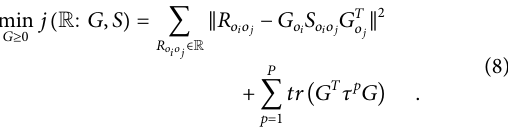
FIGURE 2 Flowchart of the proposed 3PNMF-MKL